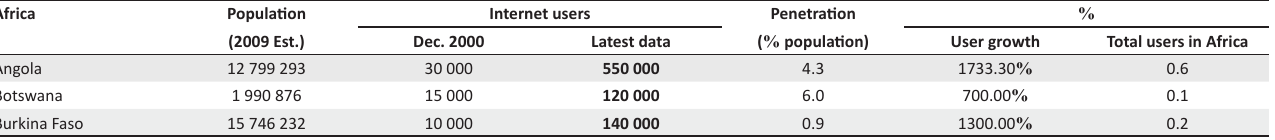
TABLE 1: Internet users and population statistics for specific countries.